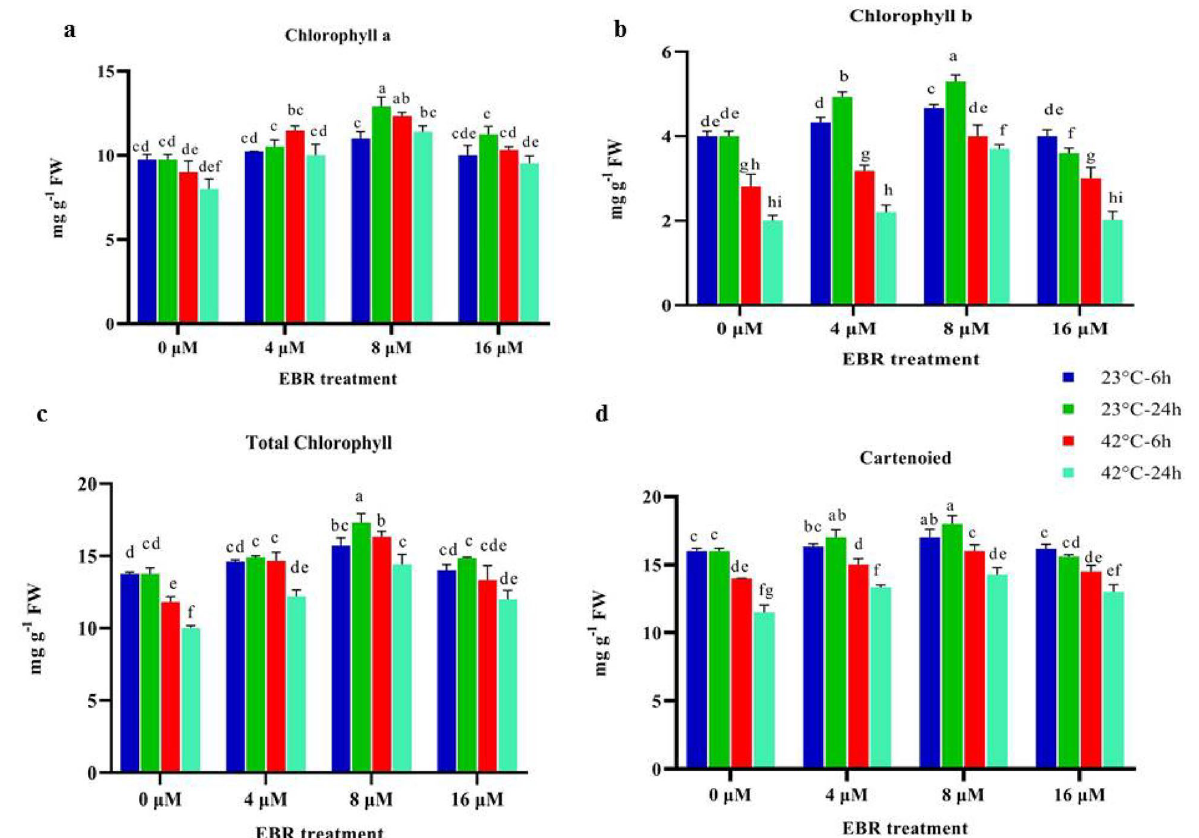
Figure 1. The effects of temperature, harvesting times, and different levels of EBR on chlorophyll a ( a ), chlorophyll b ( b ), total chlorophyll ( c ), and carotenoid ( d ). Duncan method at a 1% probability level was applied to compare mean values. The columns having similar letters had no significant